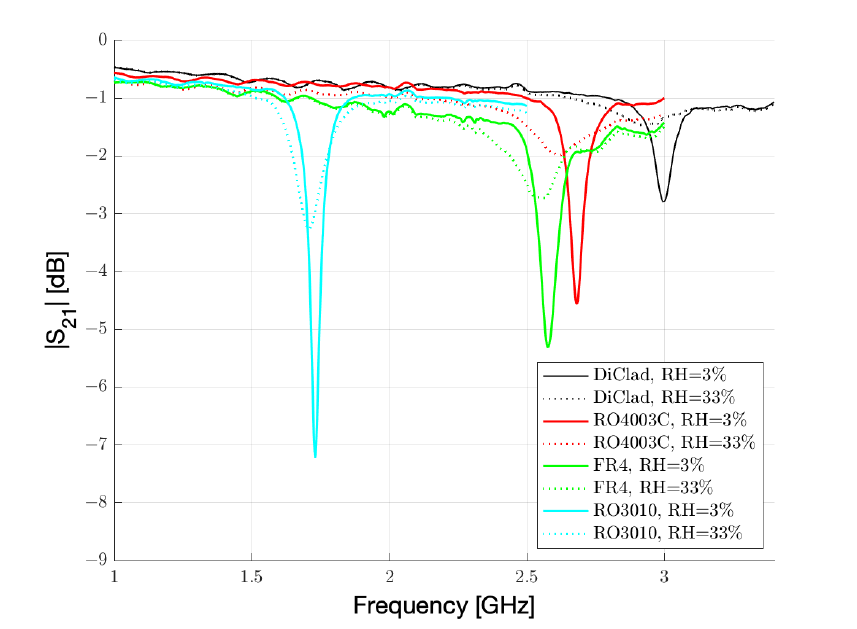
Figure 7. | S 21 | measured with VNA while the sensor cell fabricated on different substrates is exposed to 3% and 33% RH